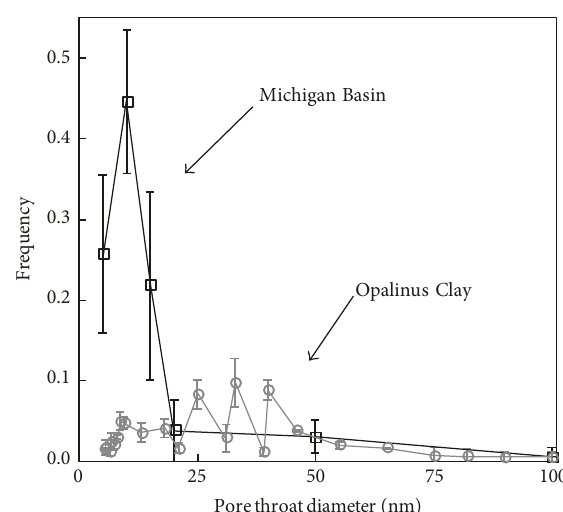
Figure 8: Pore throat diameters quantified by MIP. Opalinus clay data (adapted from [35]) from a pair of samples from the Mont Terri Rock Laboratory (borehole BCS-2, gallery 98). Data for the Michigan Basin (adapted from [36]) are from the Queenston, Georgian Bay, and Blue Mountain formation shales. The error bars represent standard